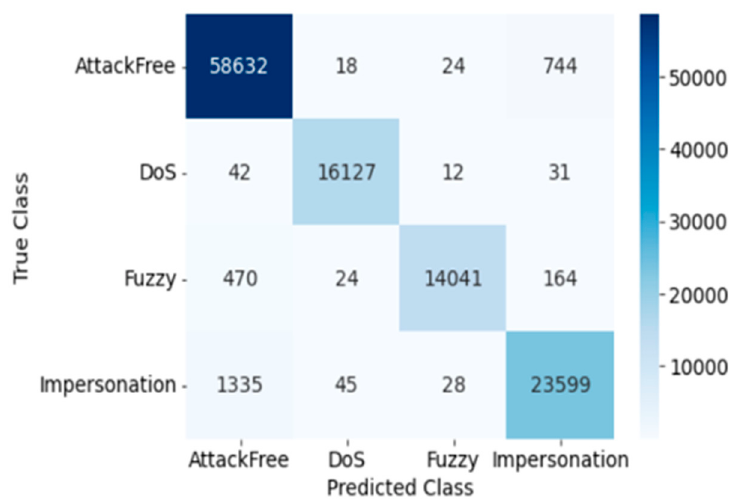
Figure 6. Confusion Matrix of SVM (Dataset 1). Table 3. Detection performance of DoS, fuzzy, impersonation, and attack-free for SVM (Dataset 1). Attack